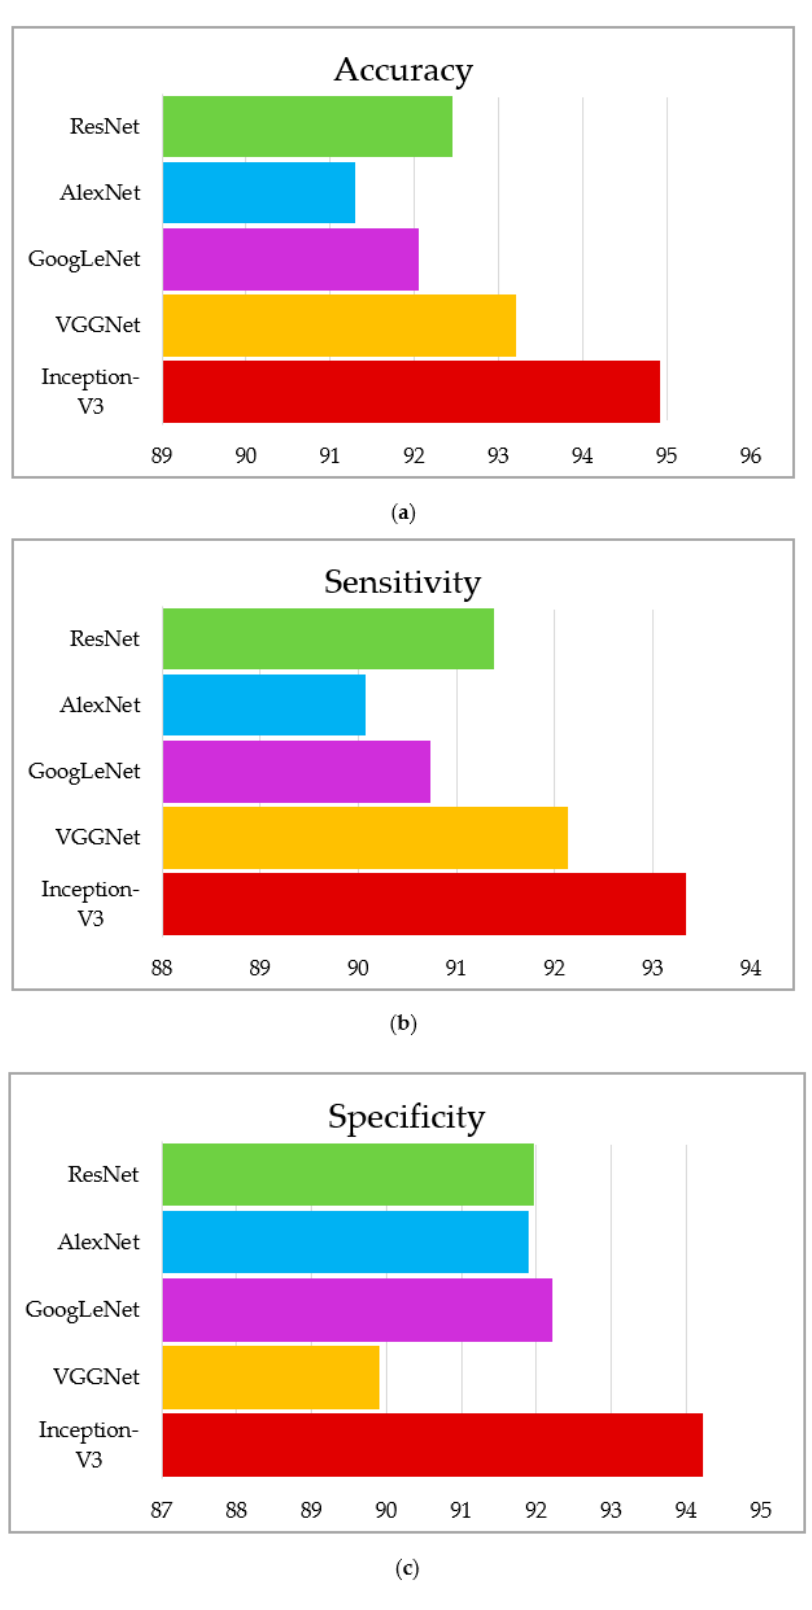
Figure 14. Graphical representation of GA-IV3, ( a ) accuracy, ( b ) sensitivity, ( c ) specificity.